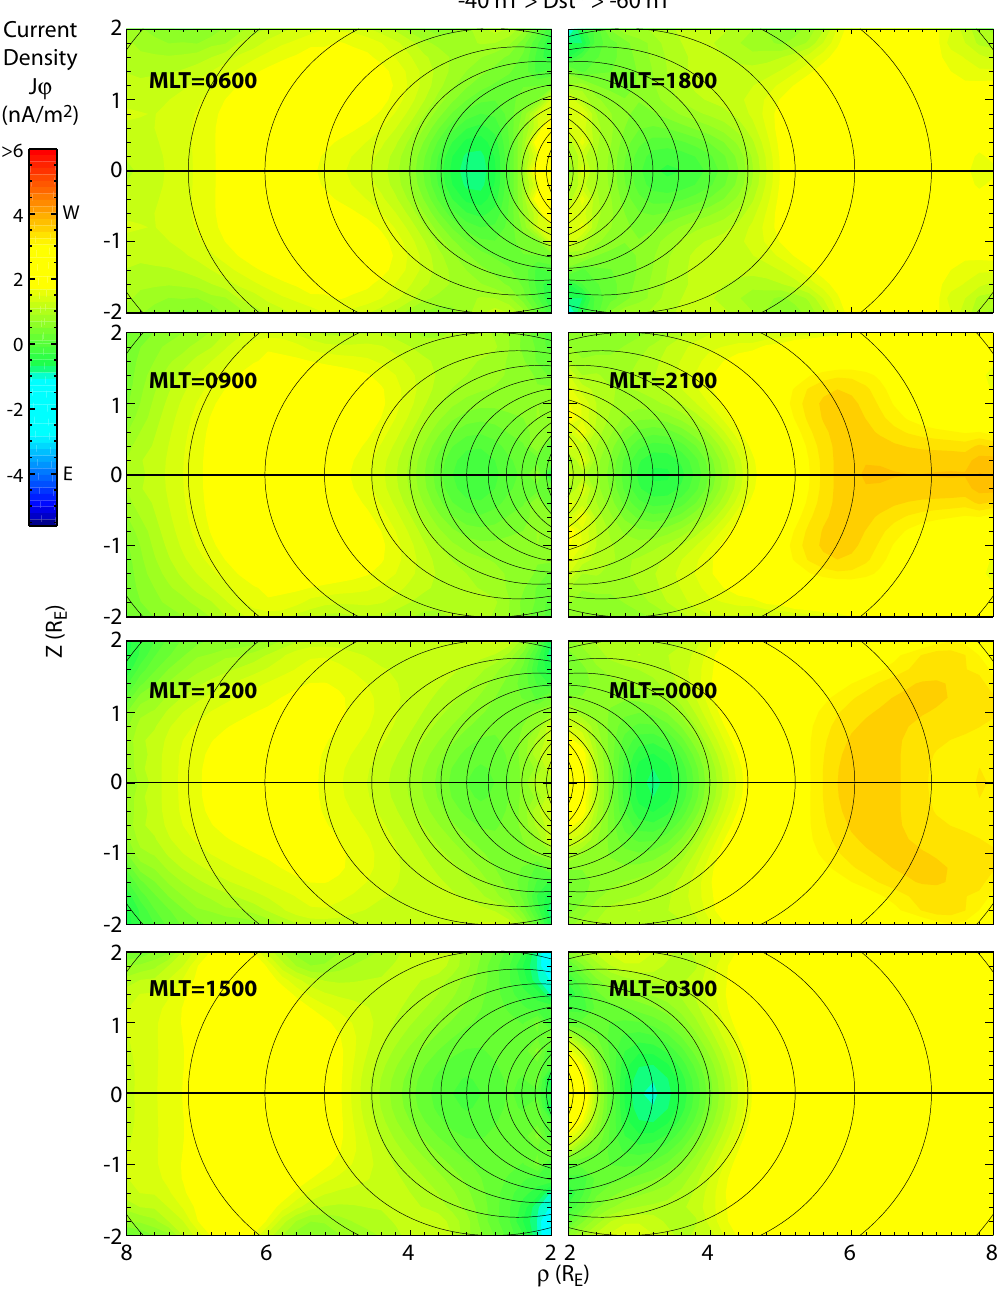
Fig. 6b. Azimuthal component of the current density (or the ring current density) with superimposed dipole field lines for each of the four D st * levels: (b) − 40nT >D st * > −